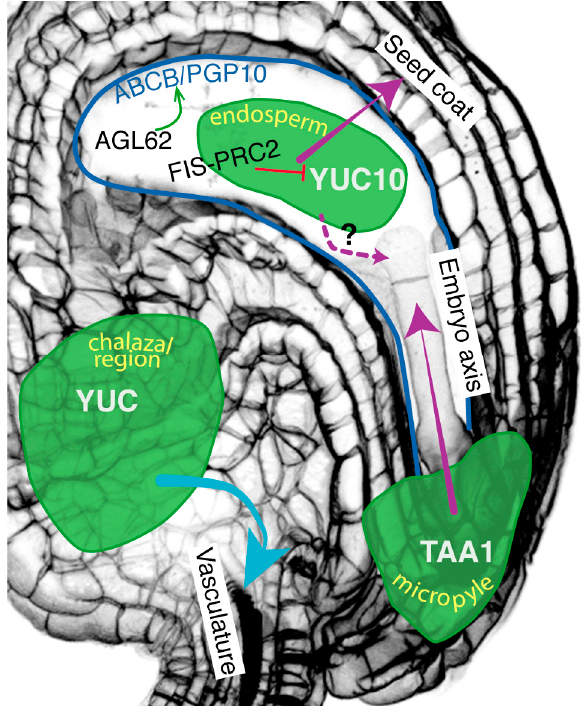
Figure 1. Auxin movement between the three seed structures after fertilization. Auxin production sites are symbolized in green. Auxin in the chalazal region promotes the specification of the vasculature in the funiculus (auxin sporophytic movement symbolized by the blue arrow). Auxin at the micropyle moves to the embryo to contribute to the formation of the embryo body axis. Auxin production in the endosperm is epigenetically repressed before fertilization by FIS-PRC2 (FERTILIZATION INDEPENDENT SEED-Polycomb Repressive Complex 2) complex (red line). This auxin moves to the integuments to contribute for the differentiation of the seed coat, through ABCB/PGP10 auxin efflux proteins. Auxin movement between different seed structures are symbolized in purple (endosperm-integuments, integuments-embryo). The expression of ABCB/PGP10 is dependent on AGL62 (green arrow). No regulated auxin movement between the endosperm and the embryo has been yet demonstrated (dotted purple arrow).